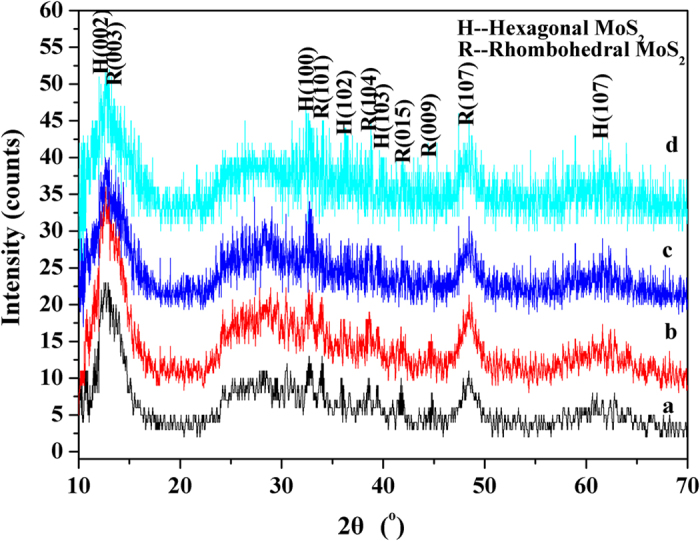
XRD patterns of the (a) MoS2, (b) MoS2:Cu2+, (c) MoS2/rGO and (d) MoS2:Cu2+/rGO nanostructures.